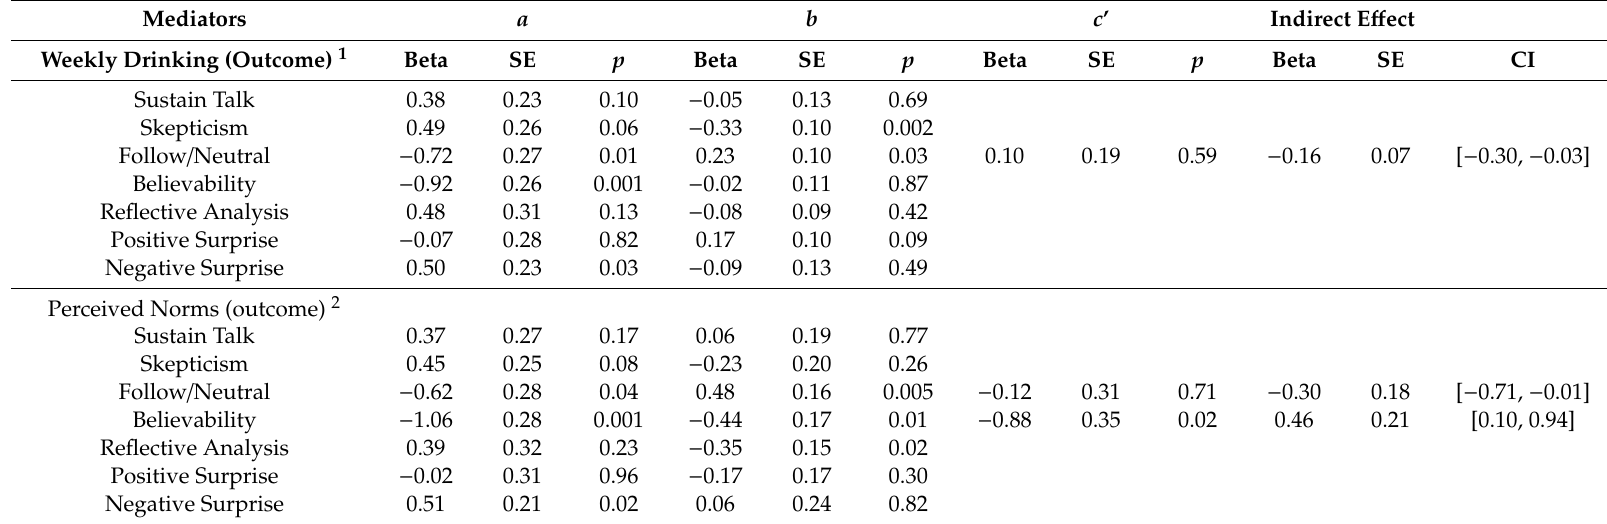
Believability − 1.06 Reflective Analysis 0.39 Positive Surprise Negative Surprise 0.51